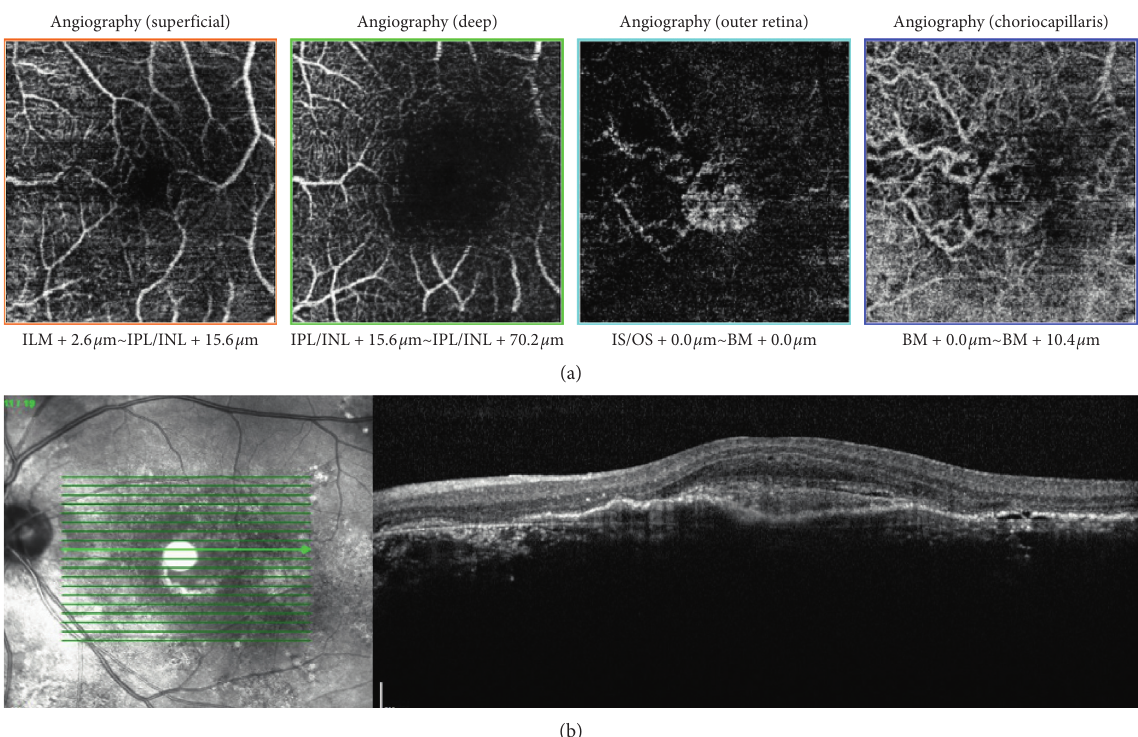
Figure 2: Association of choroidal neovascularization with flat irregular pigment epithelial detachment (FIPED). (a) Optical coherence tomography (OCT) angiography at the outer retina layer and the choriocapillaris level shows evidence of choroidal neovascularization. (b) Correlation with the OCT scan of the same patient, which shows flat irregular pigment epithelial detachment, fibrinous exudates, and evidence of shallow neurosensory retinal layer